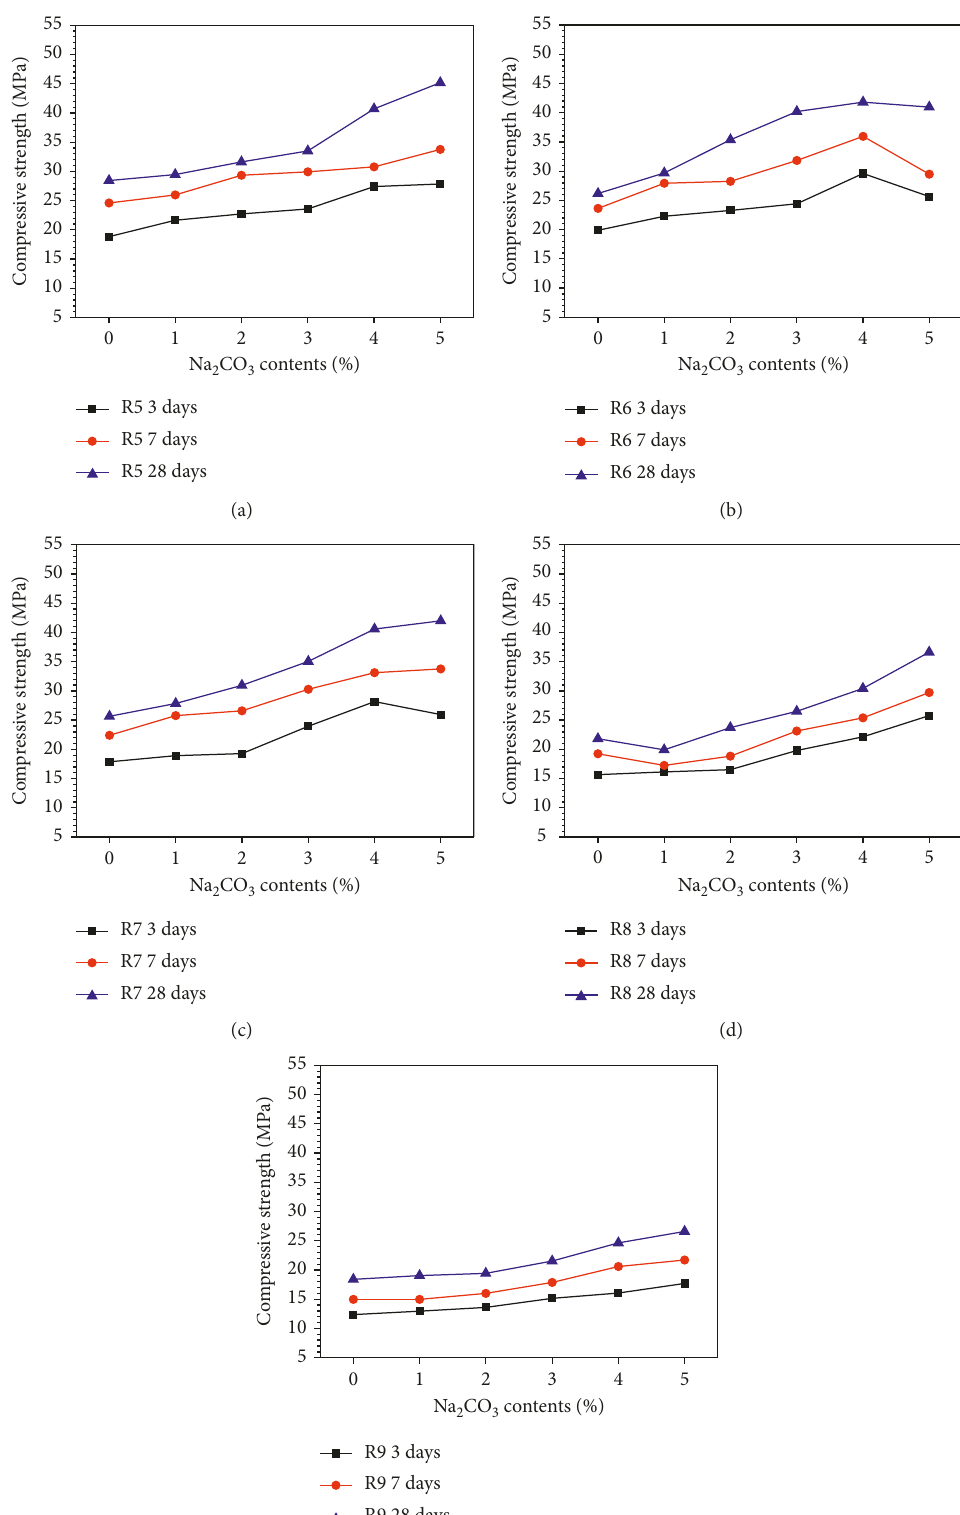
Figure 2: Compressive strengths of the Na 2 CO 3 -activated HVSC pastes with different replacement levels of GGBFS: (a) R5, (b) R6, (c) R7, (d) R8, and (e) R9